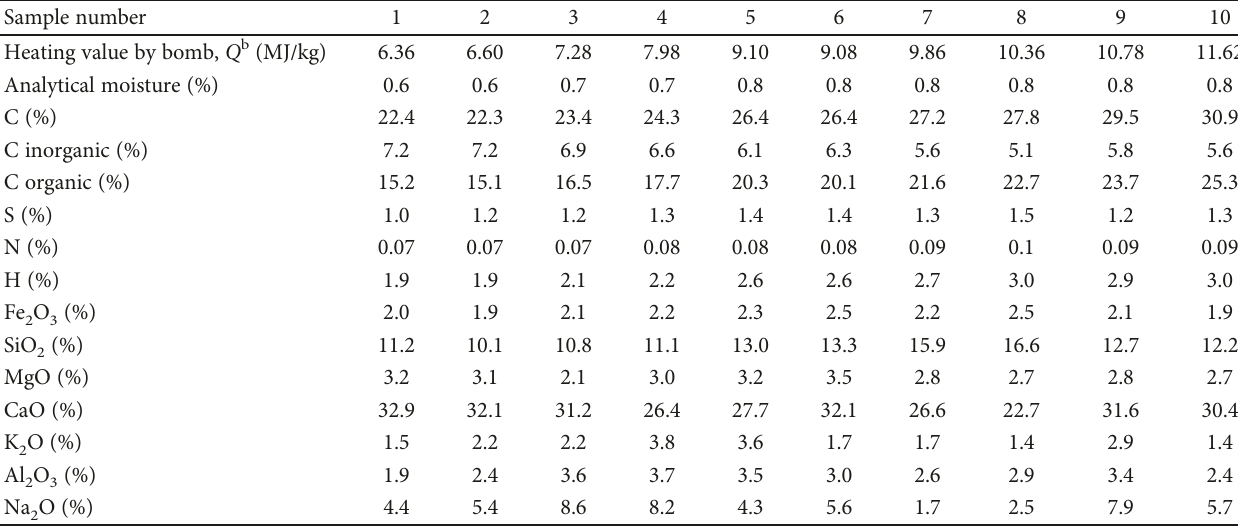
Table 1: Composition of dry